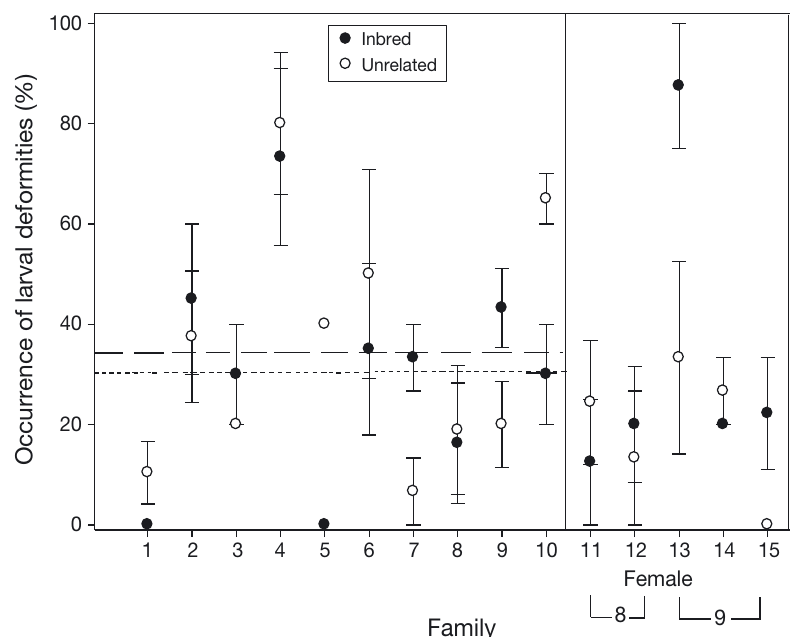
Fig. 3. Gadus morhua . Mean (±SE) occurrence of larval deformities (%) of offspring from inbred (filled circles) and unrelated (open circles) crosses of Atlantic cod at hatch. Short dashed line: mean for inbred offspring; long dashed line: mean for unrelated offspring. Families with >1 female